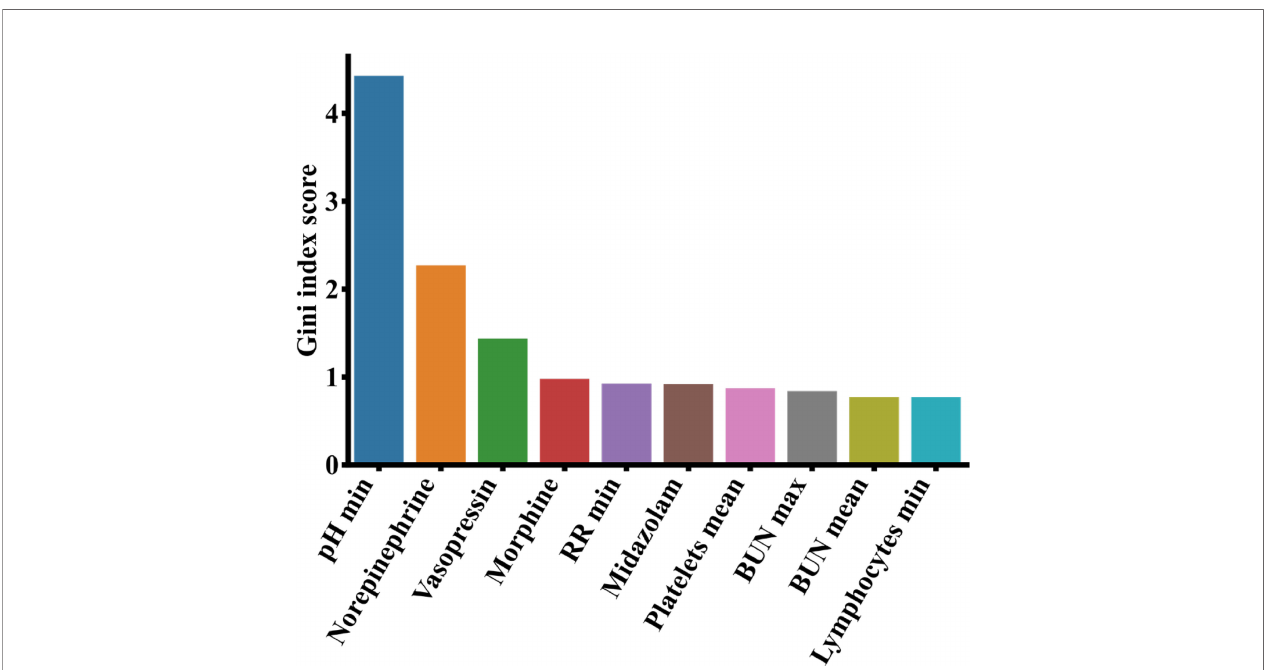
FIGURE 8 | Top 10 most important features from the MIMIC-III data based on analysis of the XGBoost model. BUN, blood urea nitrogen; RR, respiratory rate.